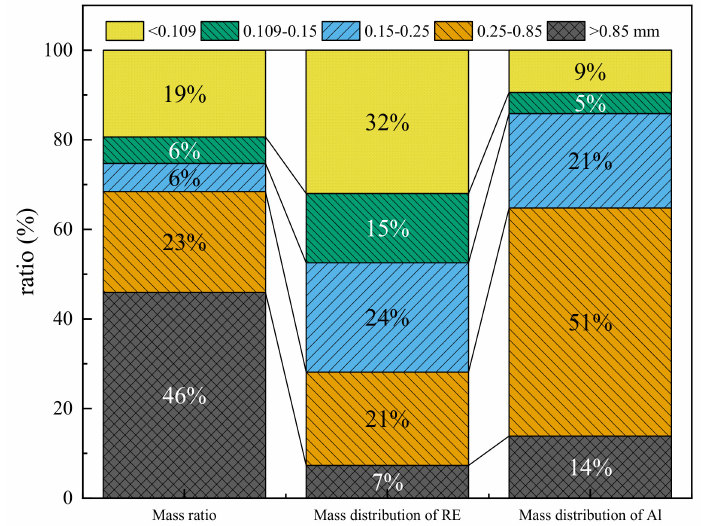
Figure 1. Mineral mass, proportion of rare earth and aluminum in di ff erent particle